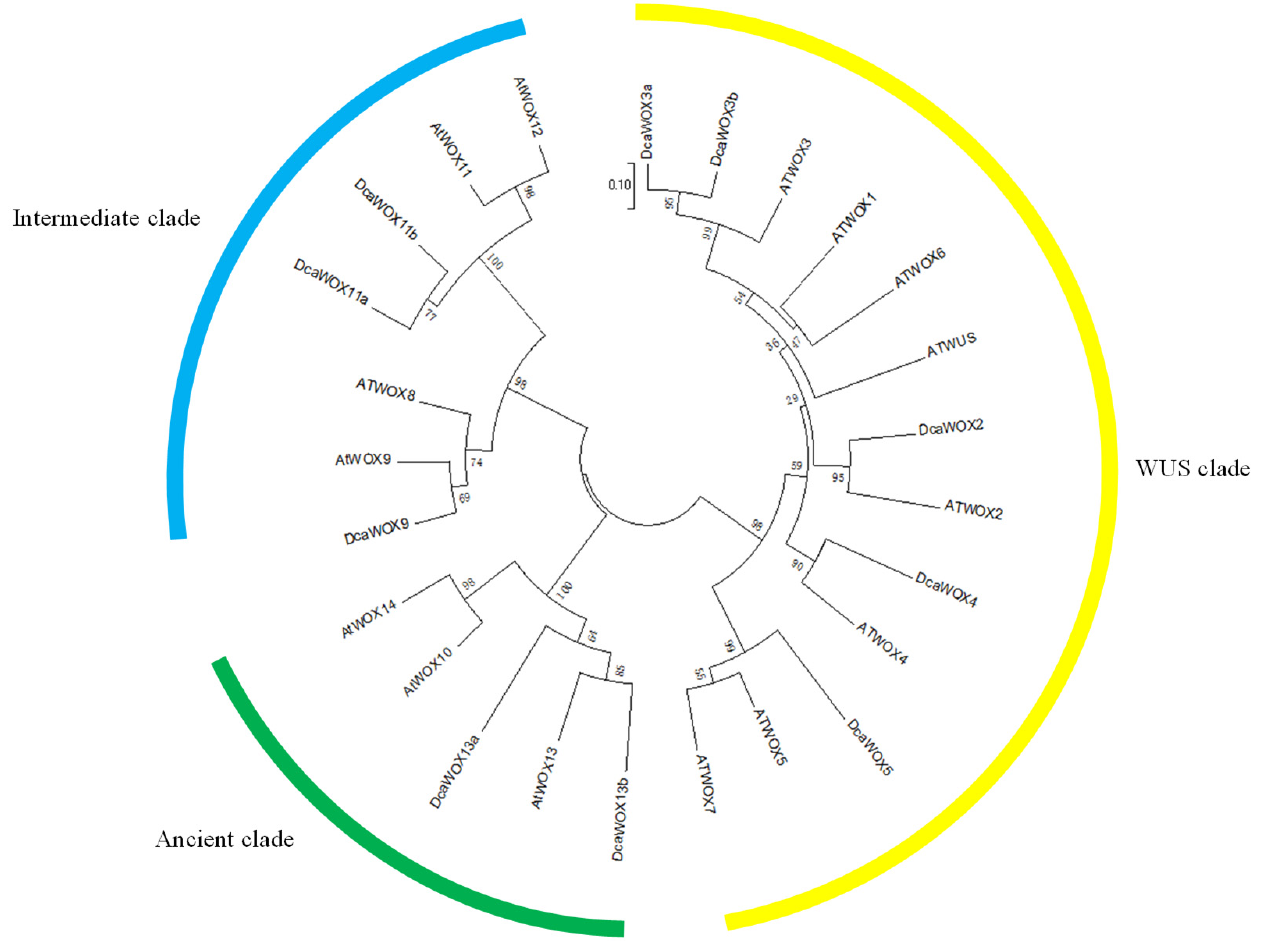
Figure 1. Phylogenetic tree of WOX proteins from D. catenatum and A. thaliana . The tree was constructed according to the neighbor-joining method implemented using MEGA 7.0 software and a bootstrap analysis with 1000 iterations.